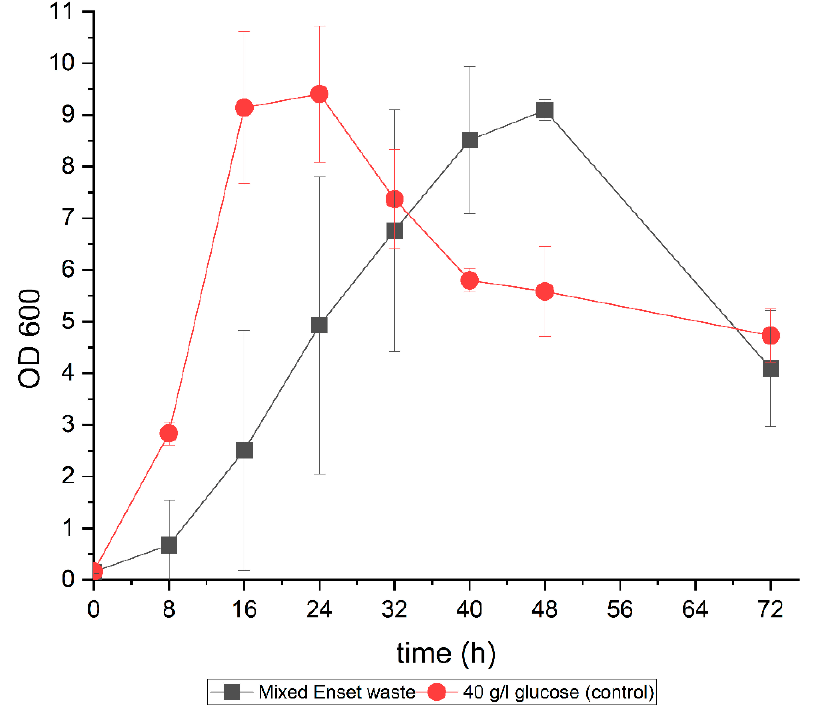
Figure 5. Growth profiles of C. saccharoperbutylacetonicum DSM 14923 during fermentation of mixed Enset waste hydrolysate and pure glucose (40 g/L) as a control.